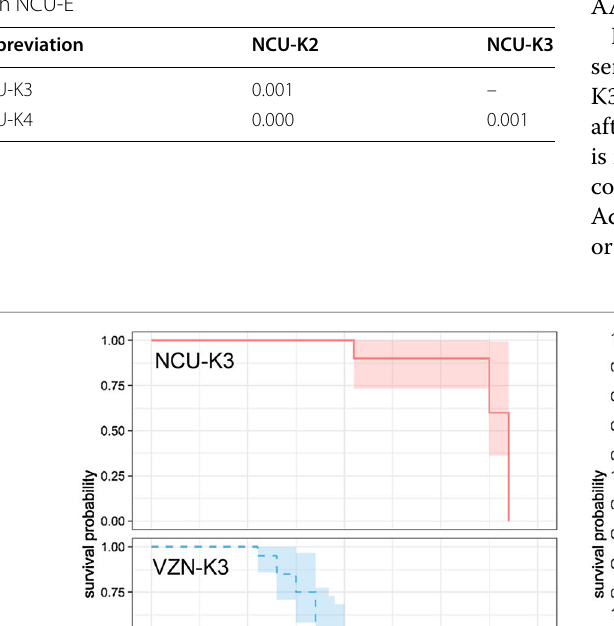
Table 4 Adjusted p value between each stake group treated